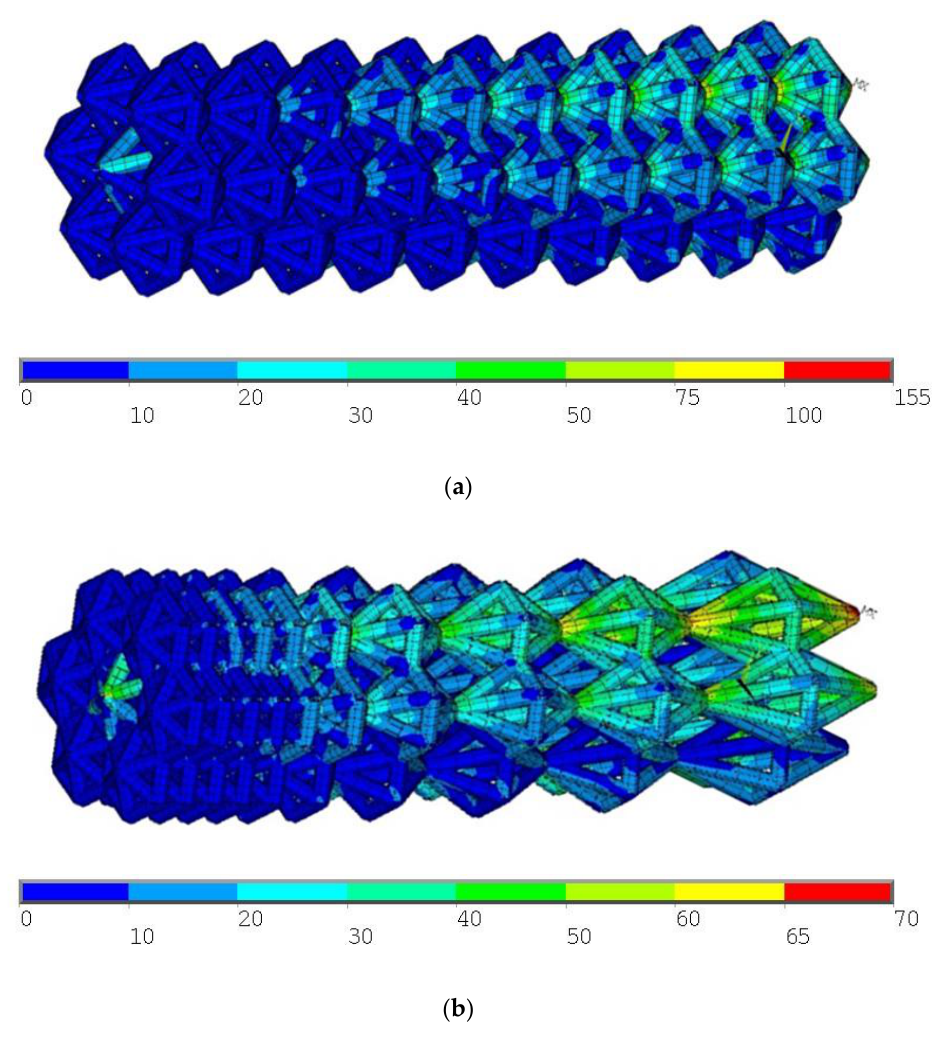
Figure 5. Initial design of the endoprosthesis ( a ) and optimized design of the endoprosthesis ( b